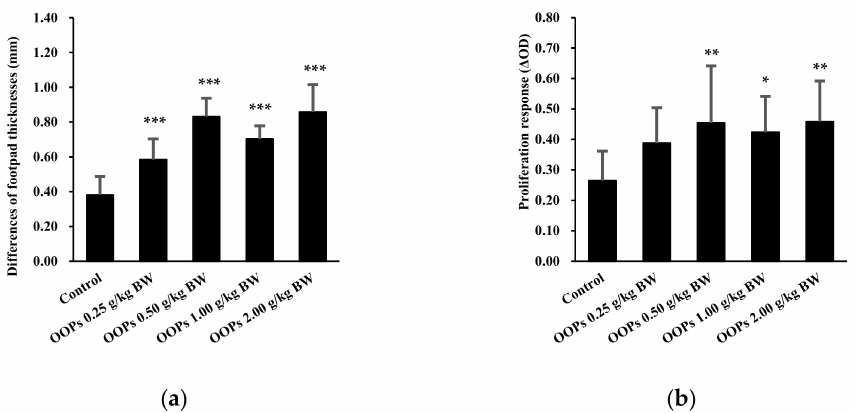
Figure 2. E ff ects of OOPs on cell-mediated immunity in mice. ( a ) Delayed-type hypersensitivity reaction to SRBCs; ( b ) ConA-stimulated splenic lymphocyte proliferation. Data was represented as mean ± SD, n = 10. * p < 0.05 vs. control group, ** p < 0.01 vs. control group, *** p < 0.001 vs. control